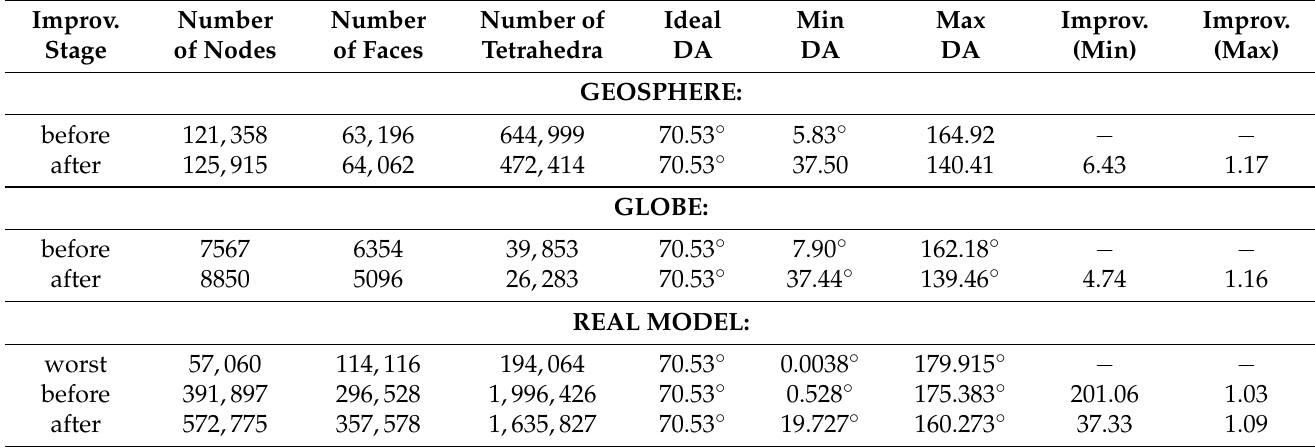
Table 9. Mesh quality improvement with Stellar software for all the models (for the real model the worst, “raw”, mesh is also included).